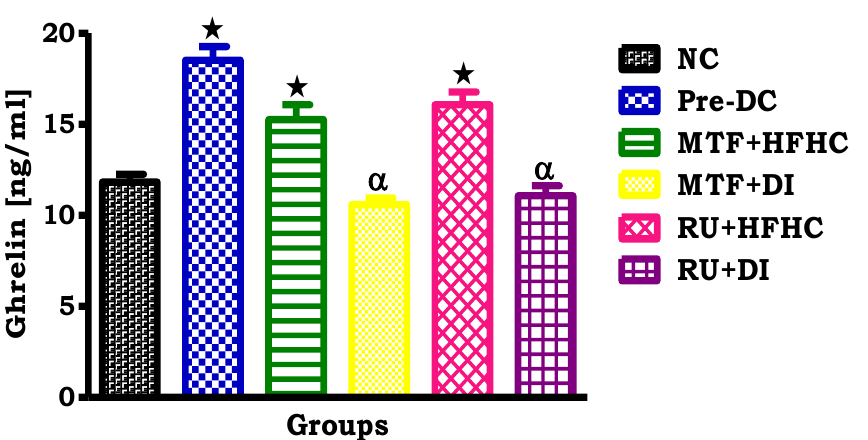
Figure 2. The effects of the ruthenium complex on ghrelin concentration of pre-diabetic animals during the treatment period. Values are presented as means ± SEM ( n = 6) in each group. * p < 0.05 by comparison with normal control (NC), α p < 0.05 by comparison with pre-diabetic control (Pre-D); Metformin and high fat high carbohydrate (MTF + HFHC); Metformin and diet intervention (MTF + DI); Ruthenium and high fat high carbohydrate (RU + MTF); and Ruthenium and diet intervention (RU + DI).